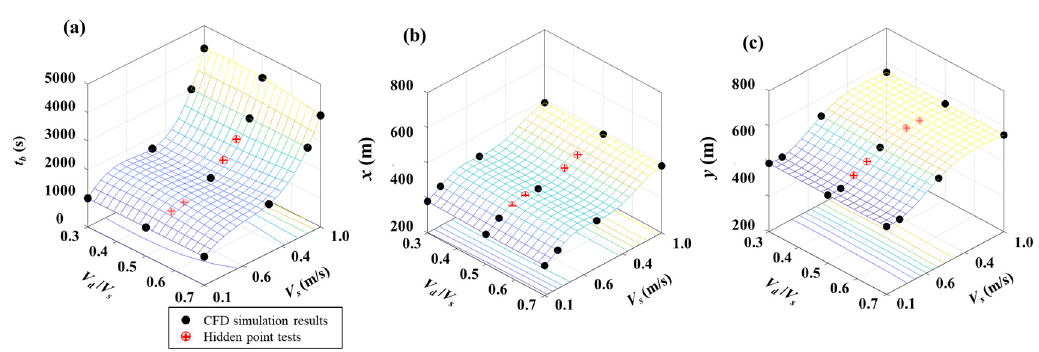
Figure 7. Contours of the ( a ) boundary arrival time, as well as the ( b ) x - and ( c ) y -coordinates of the styrene interface facing 50° from the middle point at t = 1000 s after spill starts.